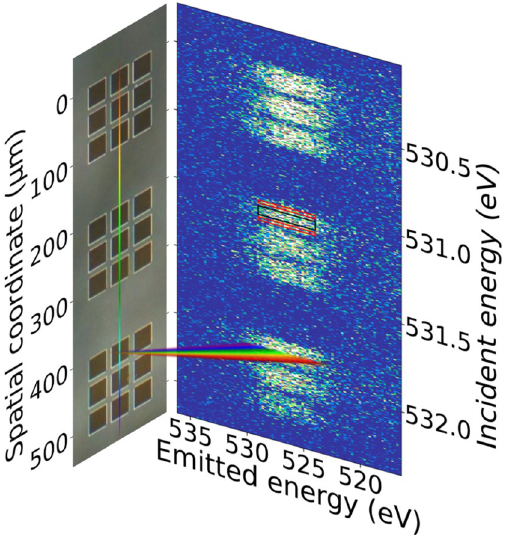
Figure 1. Imaging of the microstructured VO 2 thin film sample. Left: Optical microscopy image of the microstructures. The vertical rainbow-colored line illustrates the illuminating X-ray line focus with varying incident photon energy. Right: Background subtracted detector image of oxygen fluorescence from the microsquares with spatial resolution along the vertical axis. Three rectangles highlight the regions of interest for edge (red) and center regions (black). Note that both panels are scaled to the same vertical spatial axis. Due to the space-energy coupling along the line focus (see text), the incident energy also varies along the vertical